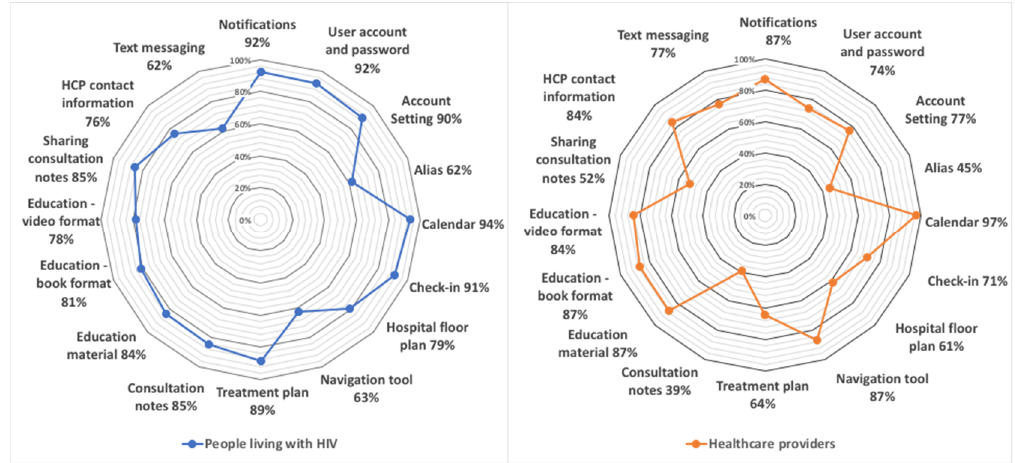
Figure 1. Participant interest in proposed Opal functions.